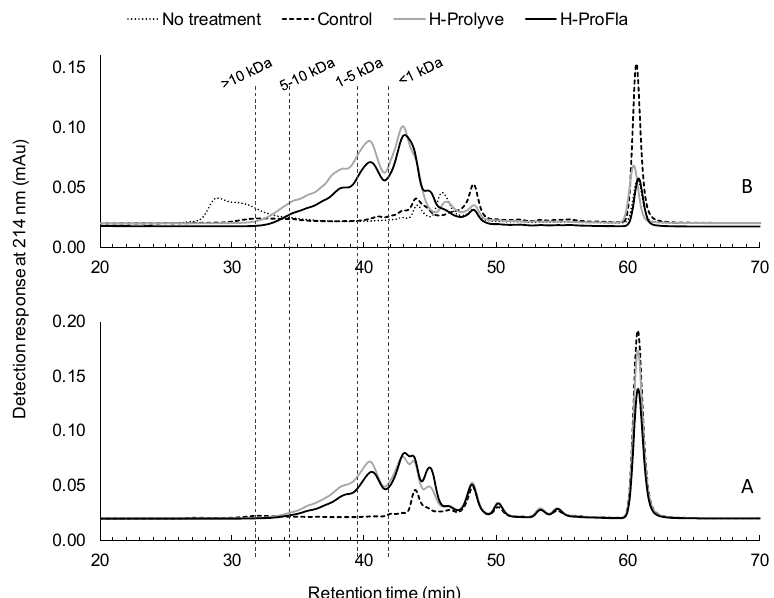
Figure 2. Gel permeation high-performance liquid chromatography profiles of Porphyra dioica blades ( A ) and protein isolate ( B ) following 2 h hydrolysis at 50 ◦ C with Prolyve ® 1000 (H-Prolyve) and a 4 h hydrolysis with Prolyve ® 1000 plus Flavourzyme ® (H-ProFla). No treatment: no enzyme addition without incubation at 50 ◦ C for 4 h; Control: samples incubated at 50 ◦ C for 4 h without enzymes. Dashed vertical lines indicate the retention times corresponding to proteins and peptides with masses < 1 kDa, 1–5 kDa, 5–10 kDa, and > 10 kDa.